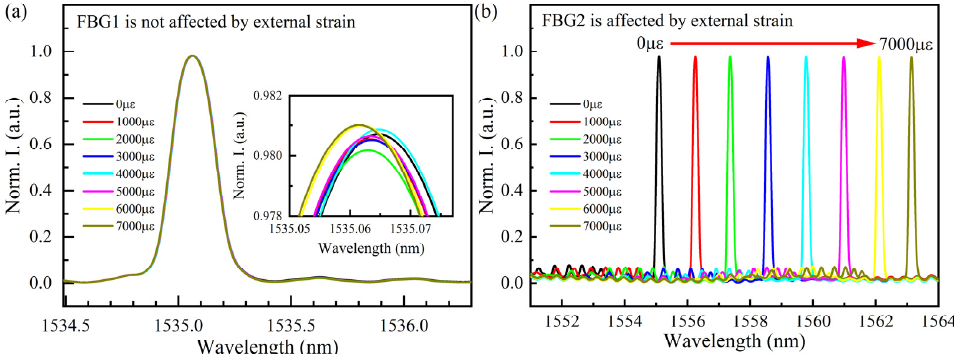
Figure 6. Normalized spectral reflectance of sensor group 1 under strain experiment: ( a ) FBG1 at different strains; ( b ) FBG2 at different strains.